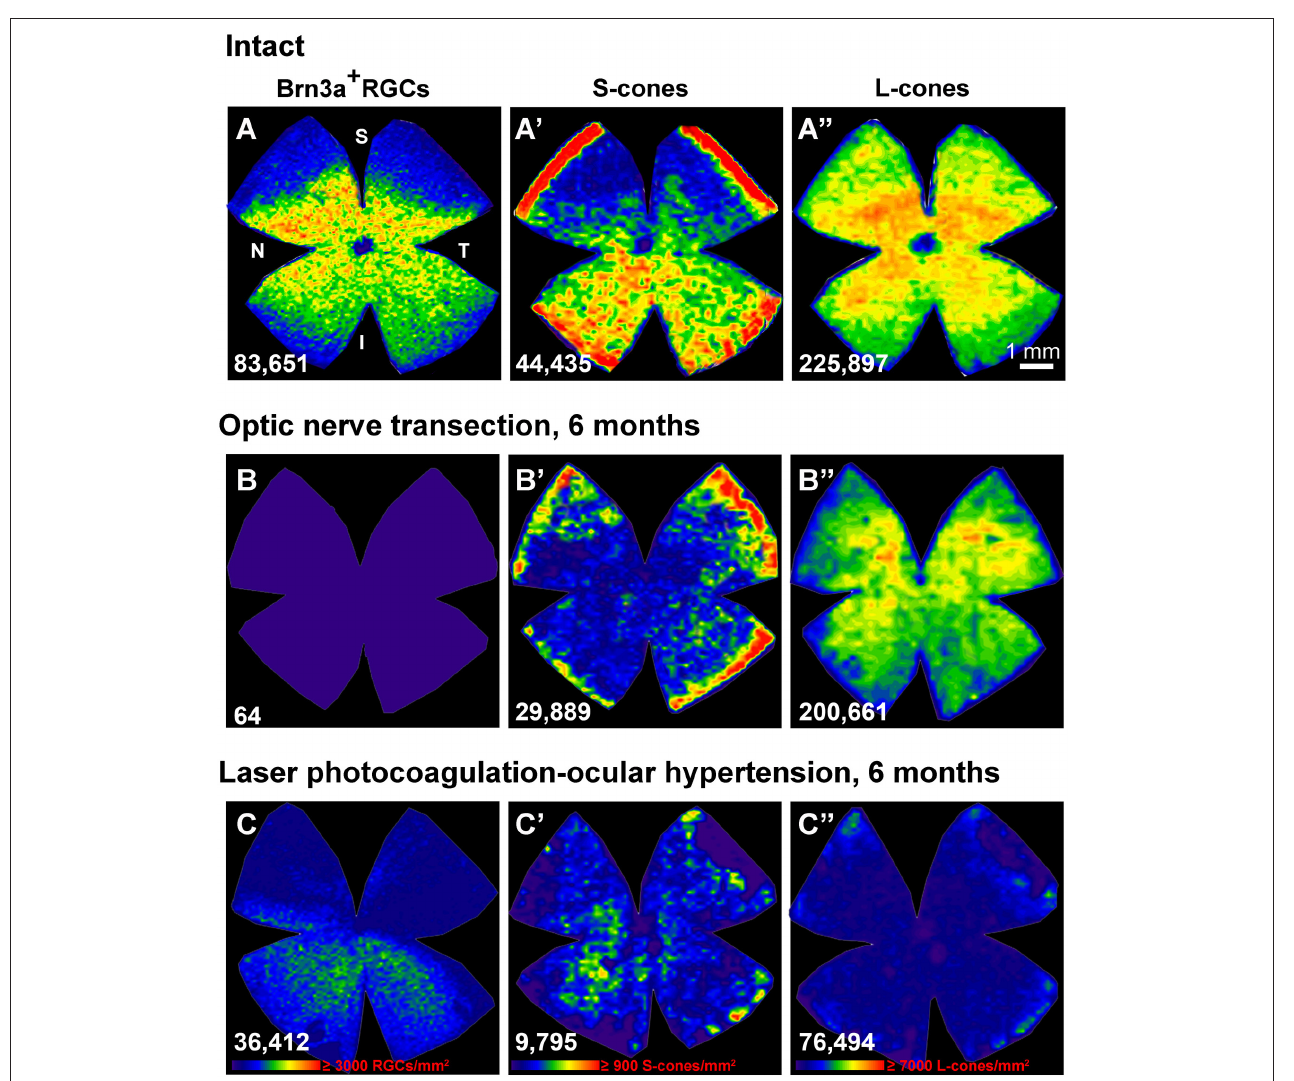
FIGURE 3 | Ocular hypertension but no optic nerve axotomy, causes the protracted loss of cone photoreceptors (A–C”) : isodensity maps showing the topography of Brn3a + RGCs (A–C) , S-cones (A’–C’) and L-cones (A”–C”) in the same retina within each group. (A–A”) : intact, (B–B”) : 6 months after axotomy, (C–C”) : 6 months ocular hypertension induced by laser photocoagulation. Isodensity color scale is found in (C–C”) and goes from 0 cells/mm2 (purple) to ≥ 3,000 RGCs/mm 2 , ≥ 900 S-cones/mm 2 or 7,000 L-cones/mm 2 (red). N, nasal; T, temporal; S, superior; I, inferior; d, days; These original isodensity maps were constructed using data from Ortín-Martínez et al.